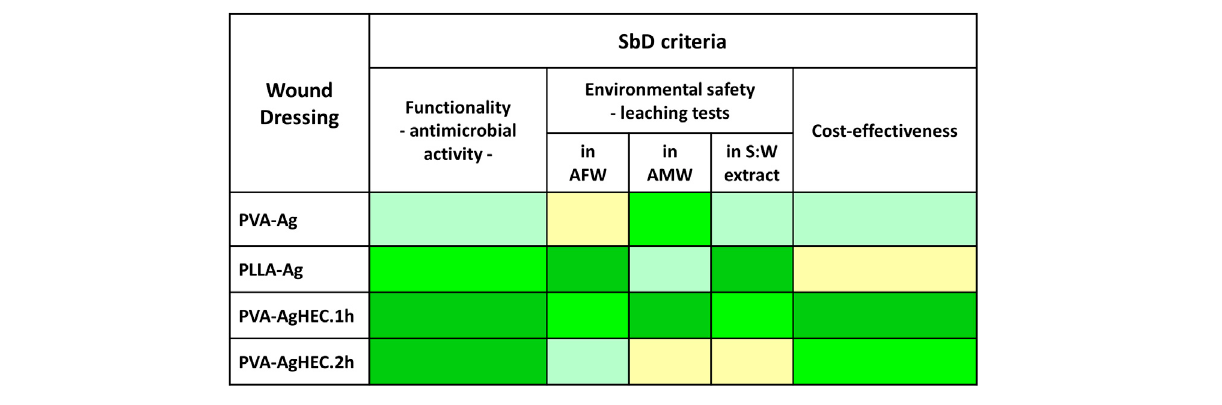
TABLE 2 Ranking of the Ag-WD alternatives according to the investigated SbD evaluation criteria. The three criteria have equal weight in the fi nal